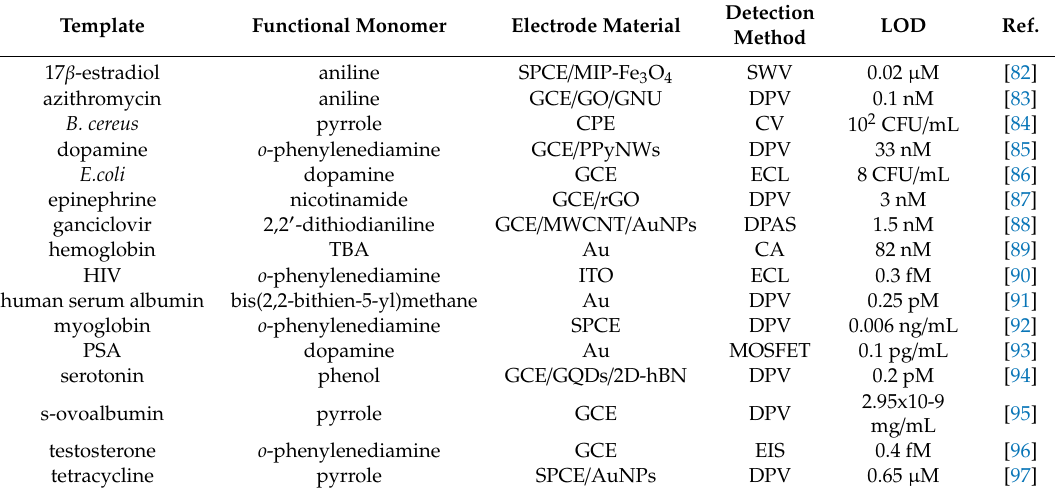
Table 1. The latest publication focused on the detection of various analytes by MIPs.